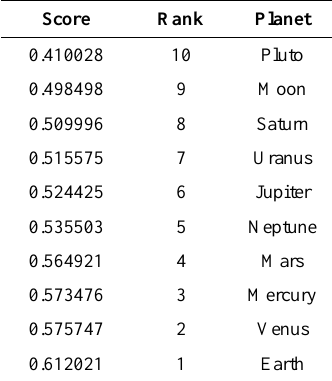
Table 5. Ranking by TOPSIS